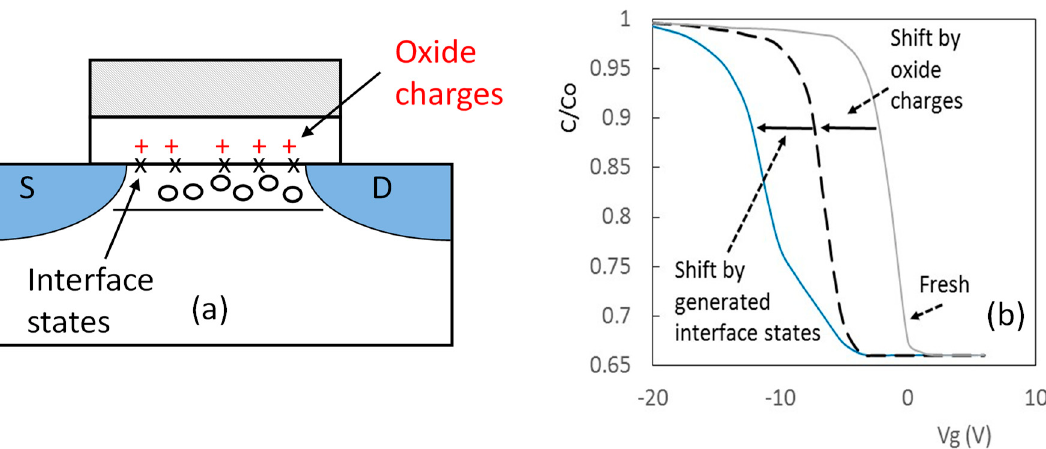
Figure 3. ( a ) A schematic illustration of oxide charges and the generated interface states; ( b ) the effect of NBTI on capacitance versus gate voltage characteristics: positive charges in gate oxide lead to a parallel shift and the generated interface states result in a nonparallel shift [1,17]. Before 2000, the gate oxide used to study NBTI was relatively thick (e.g., >4 nm) and